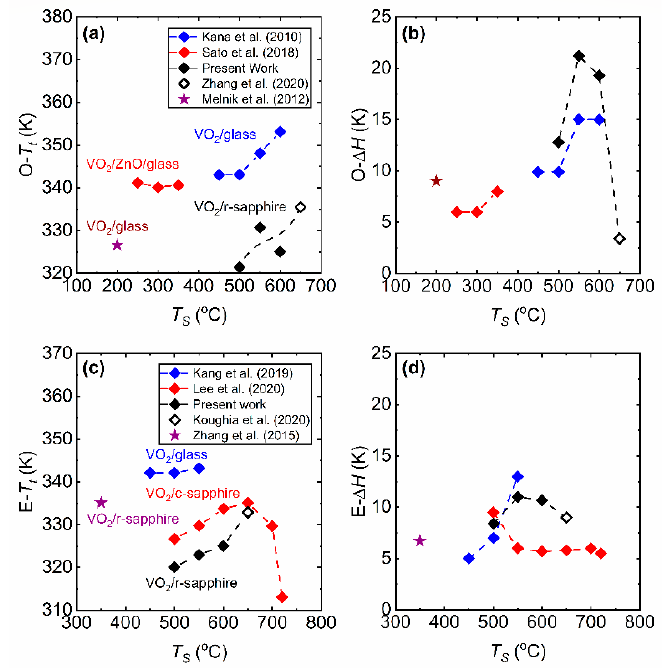
Figure 14. Comparison of VO 2 thin films deposited at various temperatures studied in different works. ( a ) Comparison of T t obtained from optical (O-) switching measurements. ( b ) Hysteresis width ( Δ H ) of the films that are obtained from the temperature ( T ) dependence of optical transmit- T tance ( ). ( c ) Comparison of phase transition temperature ( T t ) obtained from electrical (E-) switch- ing. ( d ) Hysteresis width ( Δ H ) of the films that are obtained from the T -dependence of electrical conductivity or resistance. Note that Kana et al. (2010) is [30]; Kang et al. (2019) is [57]; Koughia et al. (2020) is [32]; Lee et al. (2020) is [28]; Melnik et al. (2012) is [26]; Sato et al. (2012) is [21]; Zhang et al. (2015) is [36]; Zhang et al. (2020) is [17]. 5. Conclusions The effect of substrate temperature ( T S ) on the structural, optical and electrical prop- erties of VO 2 thin films during DC magnetron sputtering have been investigated. The re- sults showed that the T S plays a crucial role on the microstructure and hence the optical and electrical phase transition properties of the VO 2 films. It is found that T S below 500 °C favors the growth of the V 2 O 5 phase where T S of 500 °C and higher facilitate the growth of